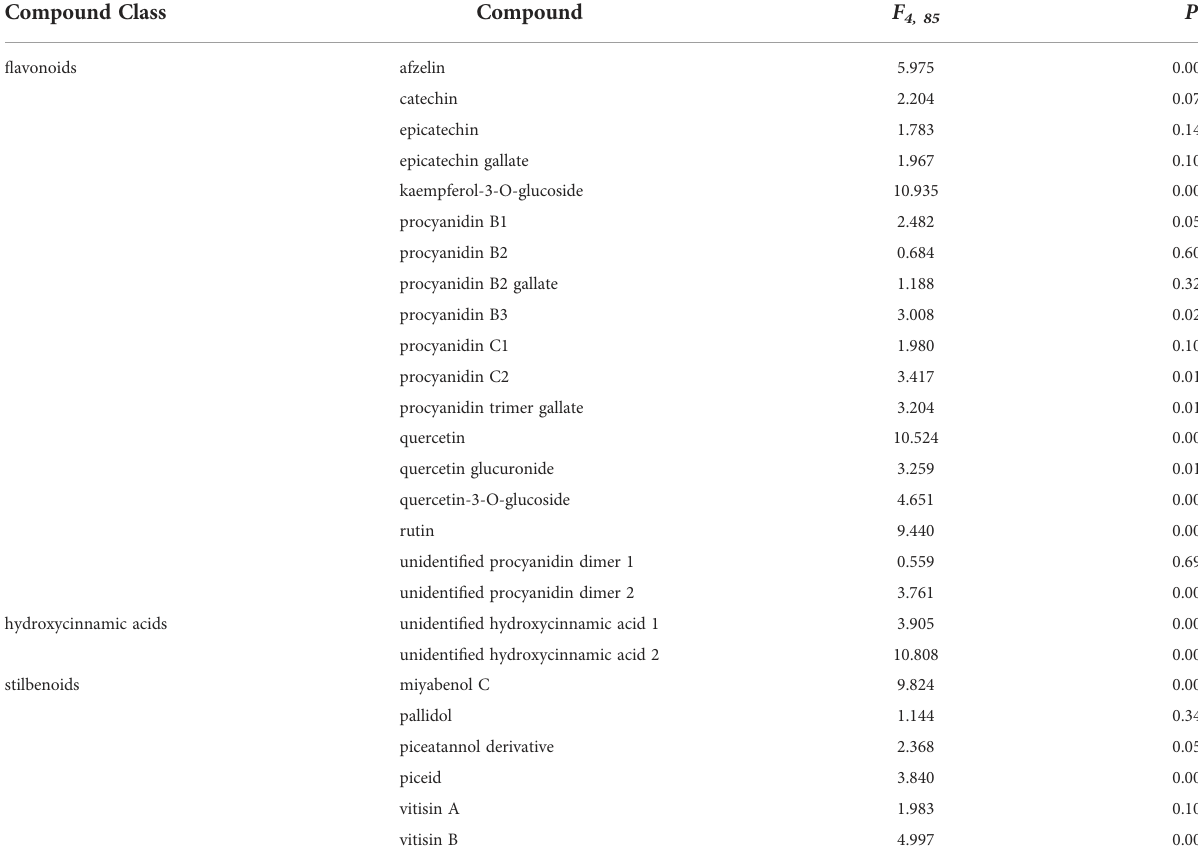
TABLE 1 Analysis of variance stats ( F- and P- values) demonstrating compounds with differing means between treatments used in this study. Compound